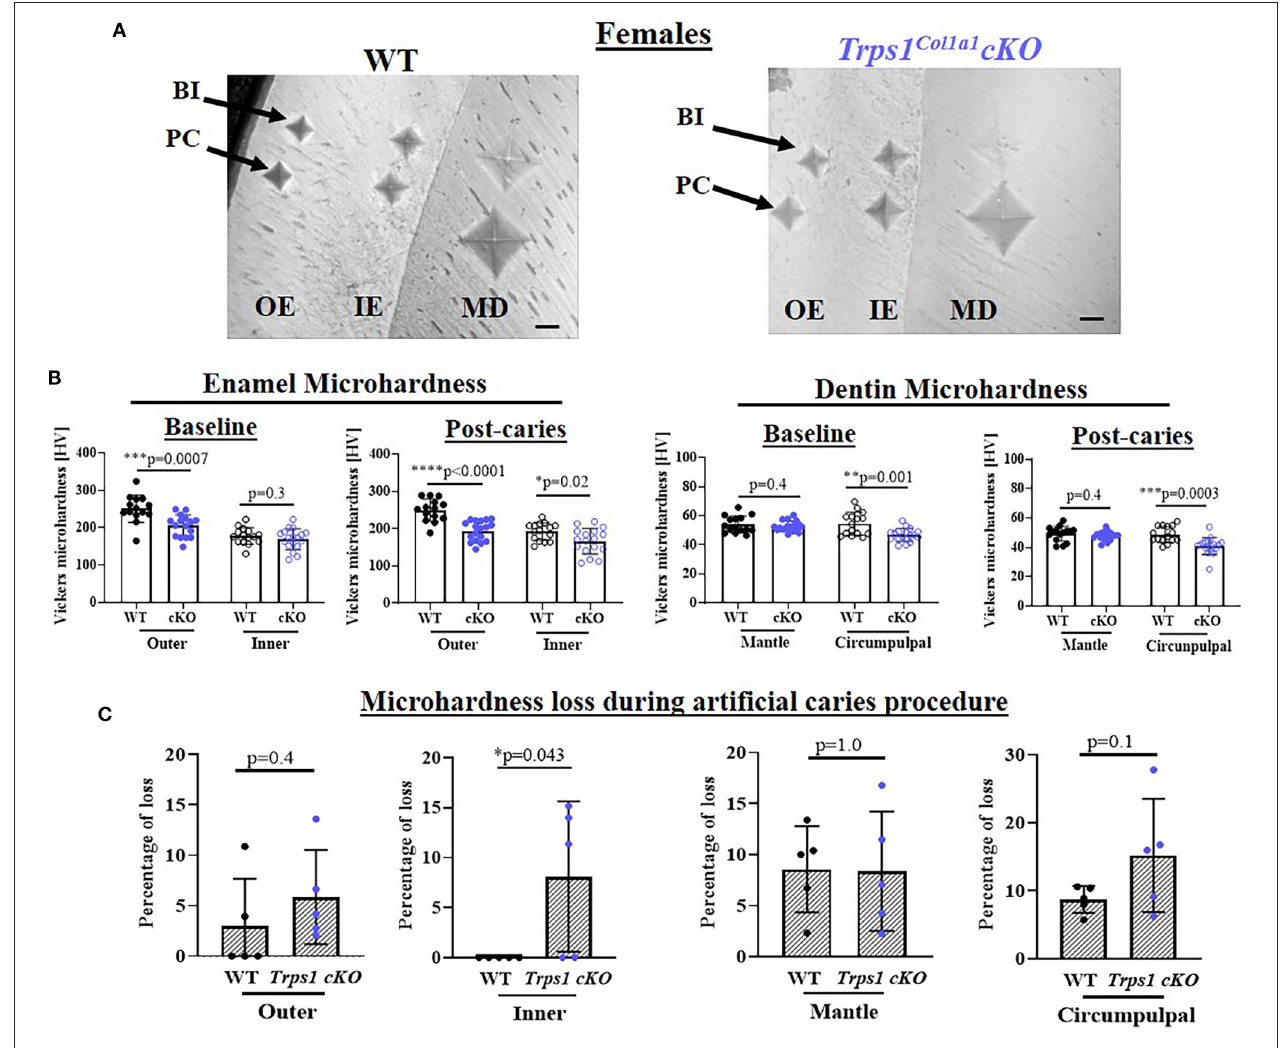
FIGURE 8 | Vickers microhardness analyses of enamel and crown dentin of mandibular first molars in 4 wk old WT and Trps1 Col1a1 cKO females. (A) Light microscopy images showing baseline indentations (BI), and indentations made after the artificial caries procedure (post-caries, PC) in the following regions: outer enamel (OE), inner enamel (IE), crown mantle (MD) and circumpulpal dentin (CPD); scale bar = 10 µ m. Three indentations (one per occlusal, middle, and cervical third of the crown) were made per region/molar. (B) Summary of the results of microhardness analyses of enamel and crown dentin. Data are shown as mean values of mechanical hardness (HV) ± SD and individual data points of all indentations performed in each region ( N = 5 molars/genotype, 3 indentations/region/molar), * p < 0.05, ** p < 0.01, *** p < 0.001 and **** p < 0.0001. (C) Graphs illustrating the percentage of microhardness loss during the artificial caries procedure. Data are shown as mean values of the % of microhardness loss ± SD and individual data points per mouse